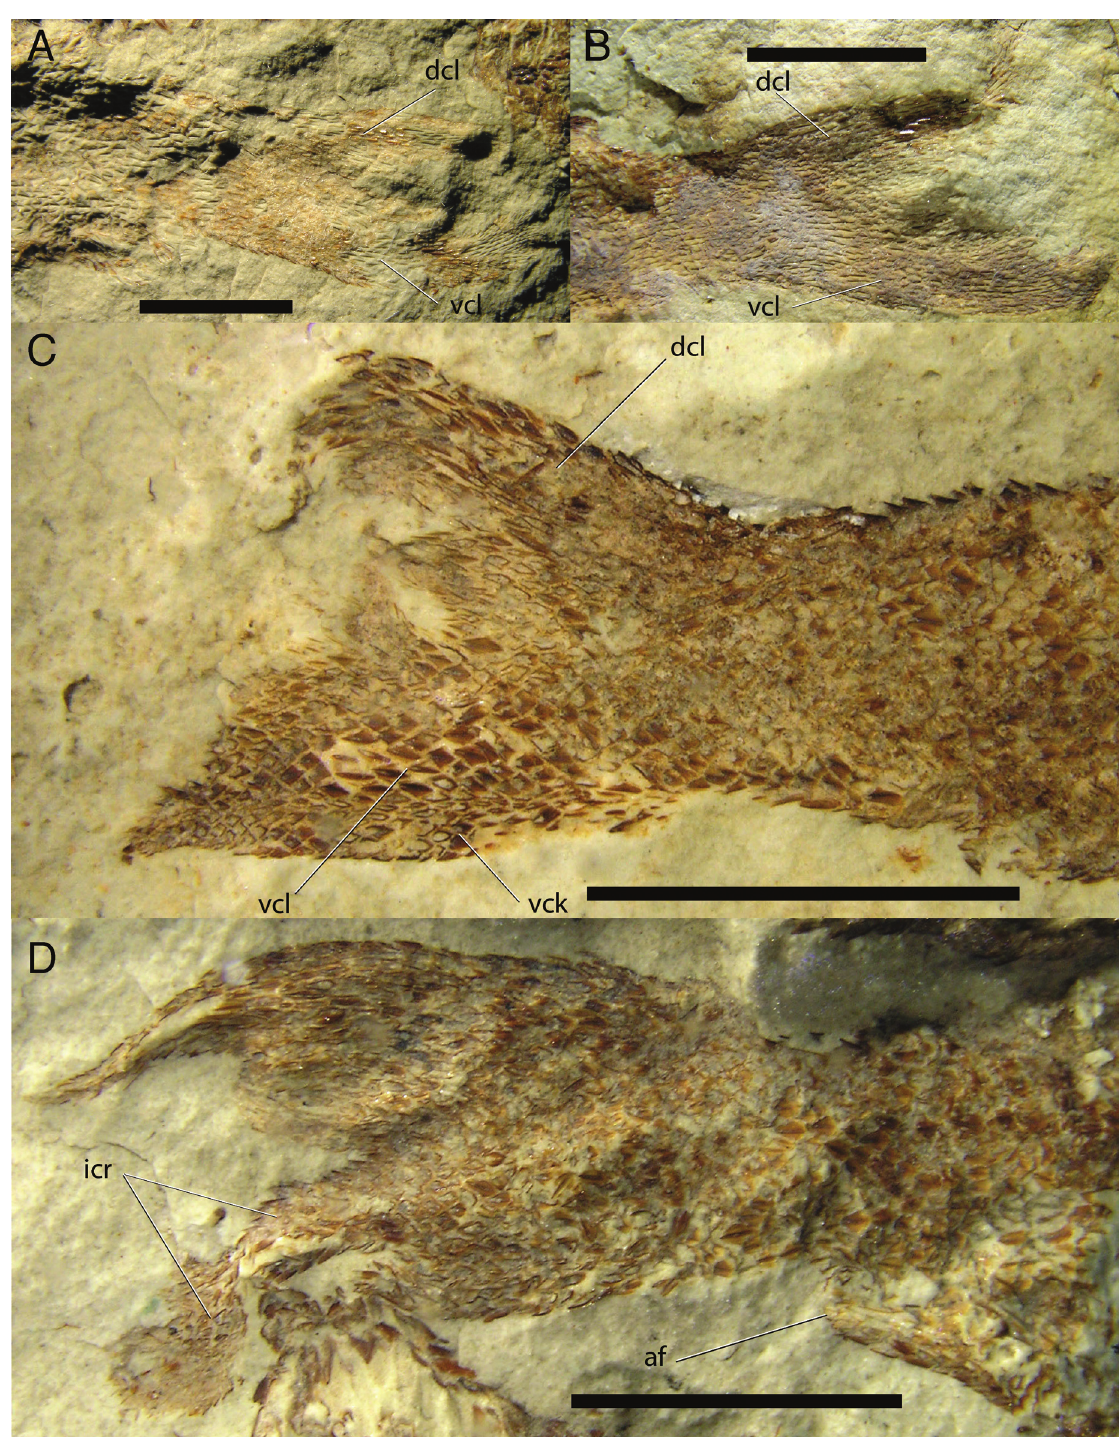
Fig. 8. Phlebolepis elegans Pander. Specimens illustrating caudal fin in lateral view, from Himmiste-Kuigu, Saaremaa, Estonia, imaged wet. A , TUG 865-3-7, caudal fin with converging main lobes; B , TUG 865-5-26, with diverging main lobes more completely preserved than most (note dorsally deflected termination of dorsal caudal lobe); C , TUG 865-4-1, with strongly diverging main lobes and fairly complete fin web; D , TUG 865-9-1, one large interior ray folded down over top of the ventral lobe. Scale bars are each 1 cm. Abbreviations: af, anal fin; dcl, dorsal caudal lobe; icr, interior caudal ray; vcl, ventral caudal lobe; vck, ventral caudal